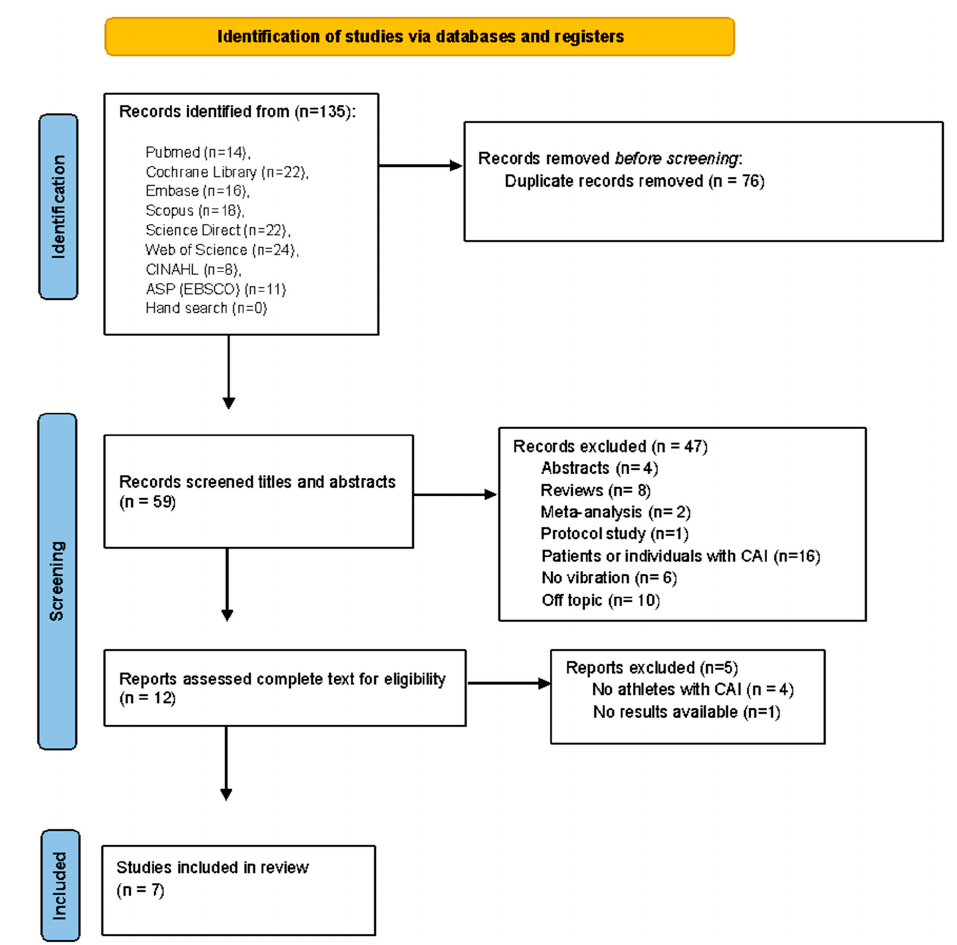
Figure 1. PRISMA flow diagram of the study selection process.